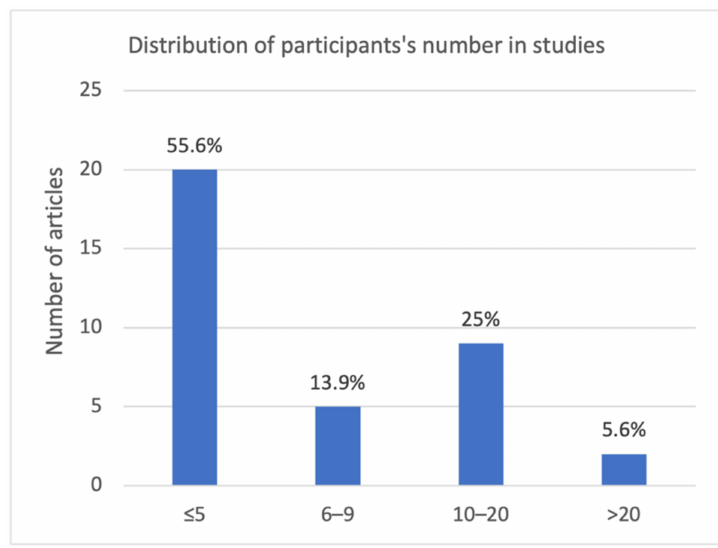
Figure 3. Distribution of participants’ number in